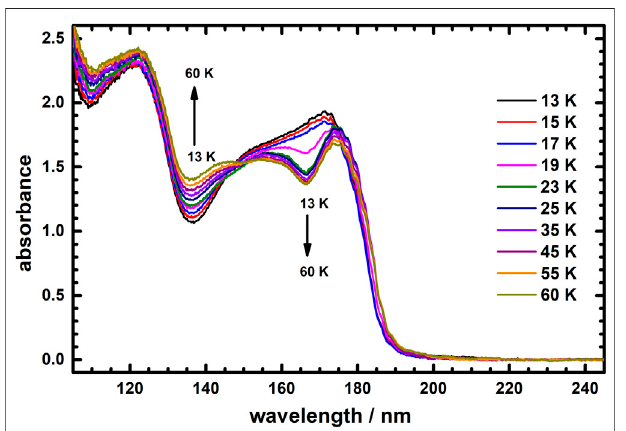
FIGURE 3 | Vacuum ultraviolet absorption spectra of icy C FIGURE 2 | Absorption spectra of icy C 2 H 4 recorded at temperatures at temperatures 13, 15, and 17 K in the wavelength range 105 – 200 nm. 13,15,17,19,23,25,35,45,55,and60 Kinwavelengthrange105 – 245 nm.